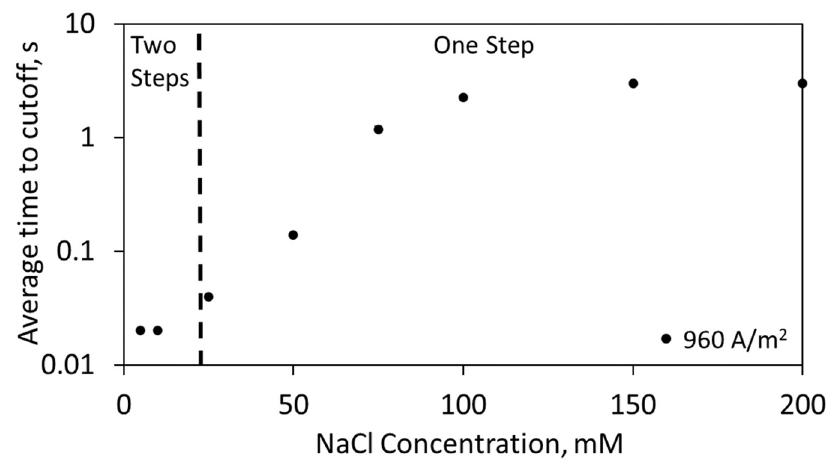
Figure 6. Average time to potential cutoff when run for 3 s at 960 A/m 2 in 20 mM Na 2 SO 4 at 25 °C. Note that 150 and 200 mM NaCl never reached the cutoff. The sweep methodology only required 1 step to resolve 25 to 200 mM NaCl. Note that the time to potential cutoff was used as the signal for 25–75 mM, and the transition time was used to resolve 75–200 mM. For 5 to 15 mM, only two sweep steps were needed.